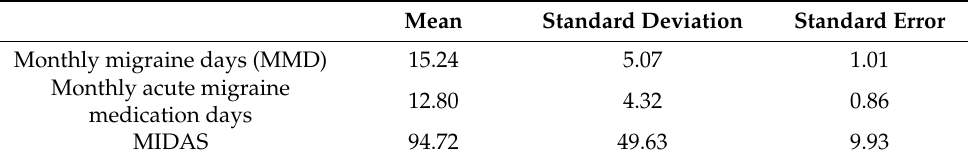
Table 3. Baseline clinical parameters.